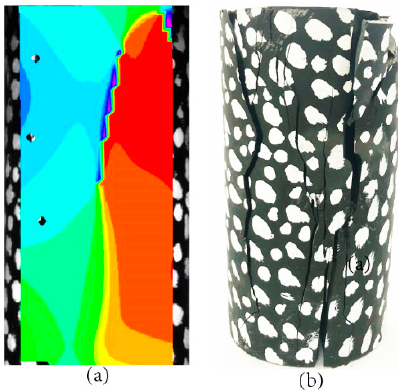
Figure 10. Cloud map and photo in post-peak stage for AS-3 specimen: ( a ) principal strain direction field cloud; ( b ) final pattern of specimen after